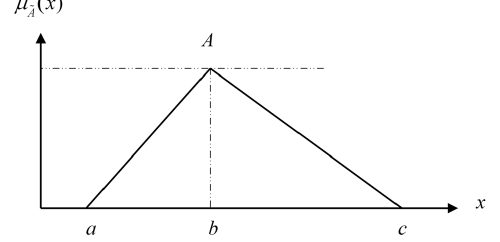
Table 2. Linguistic terms for the preference rating of alterna-